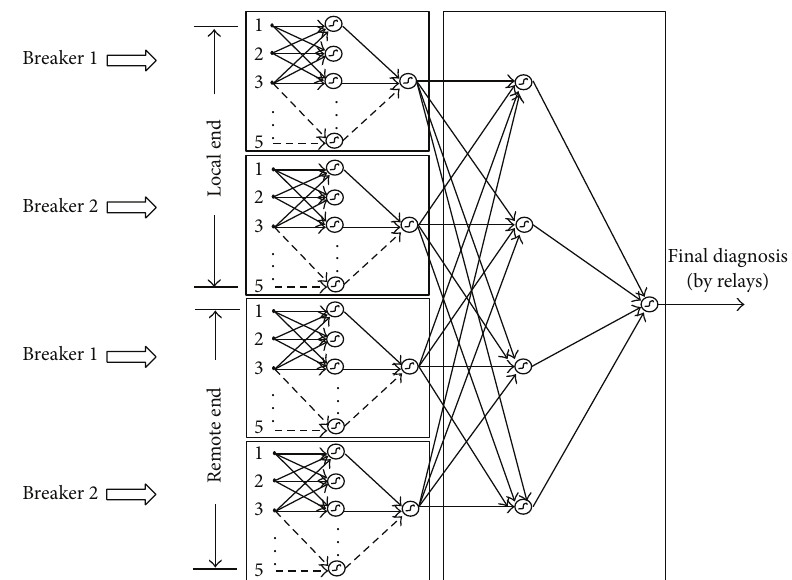
Figure 3: Modular network for the failure diagnosis by protection schemes.